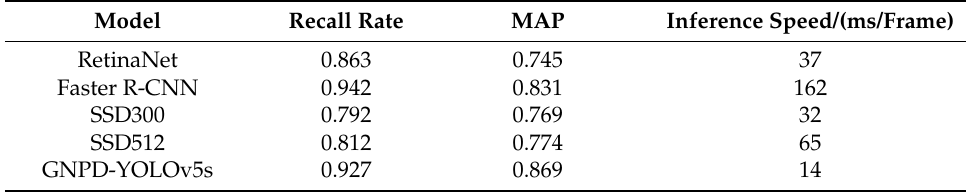
Table 2. Performance comparison of mainstream recognition algorithm